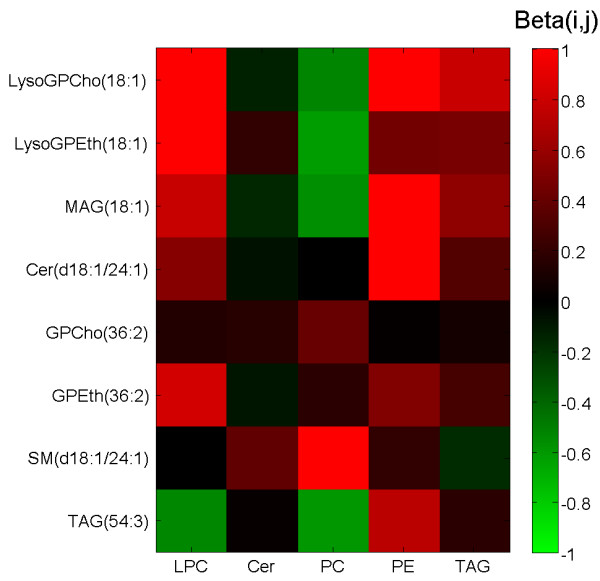
The β matrix values for selected liver lipid components. The β matrix values are shown for 8 illustrative lipid molecular species of different functional class and for all internal standards used (abbreviated as shown in Table 1). The LPC has expectedly high influence on monoacyl lipids. As one would have expected based on chemical structure, the sphingomyelin, which does not have its own class-specific internal standard, is influenced most by ceramide (Cer) and phosphatidylcholine (PC) standards